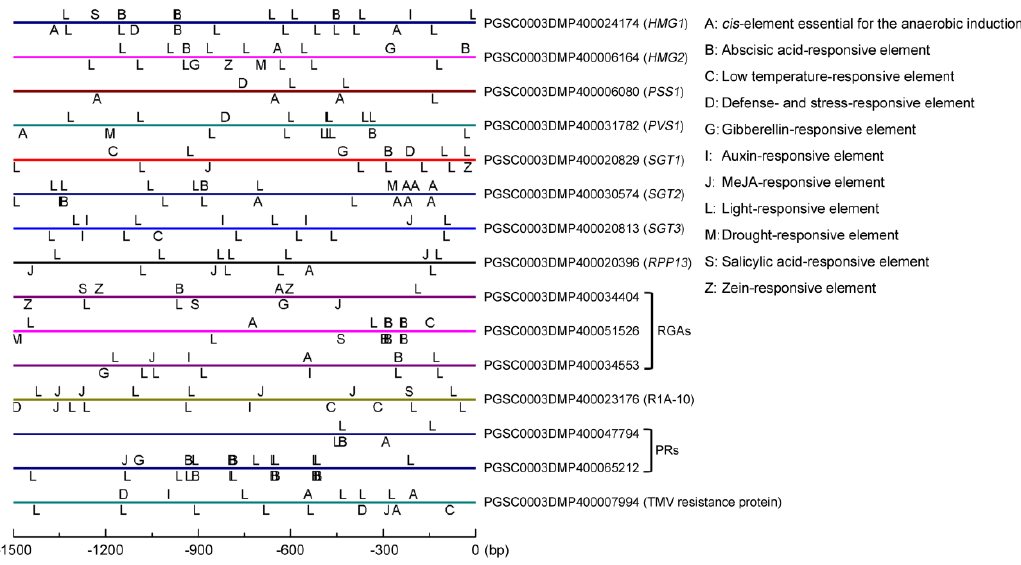
Figure 7. Distribution of cis -elements in the promoter region of seven SGA biosynthetic genes ( HMG1 , HMG2 , PSS1 , PVS1 , SGT1 , SGT2, and SGT3 ) and eight disease resistant genes. For disease resistant genes, one of these encodes the disease resistant protein RPP13 (PGSC0003DMP400020396), three for disease resistant protein RGAs (PGSC0003DMP400034404, PGSC0003DMP400051526 and PGSC0003DMP400034553), one for late blight resistance protein R1A-10